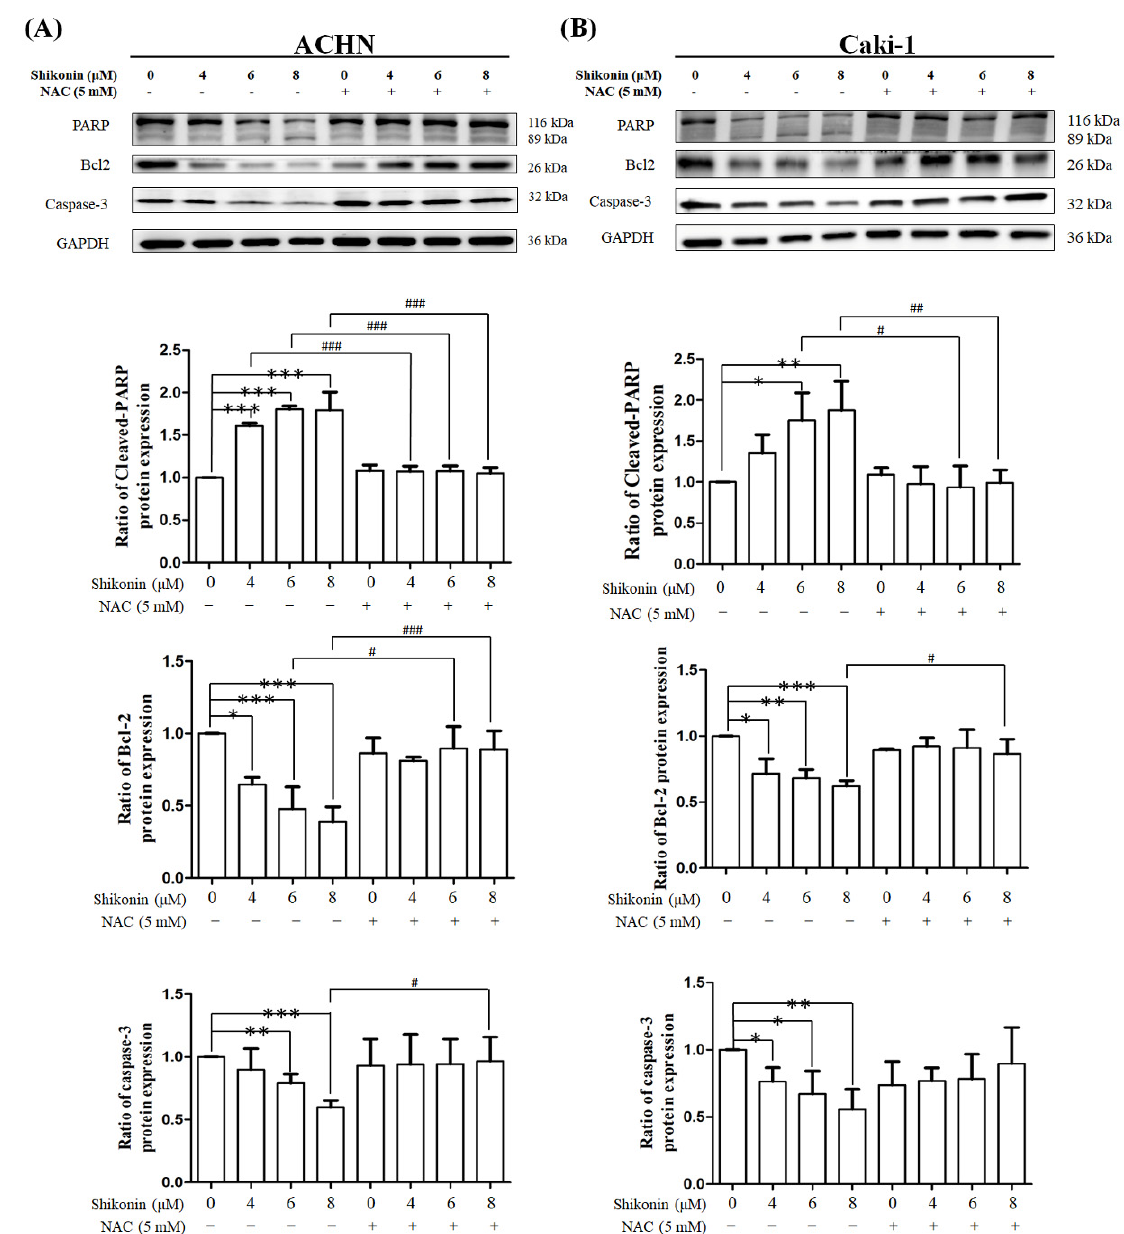
Figure 6. Shikonin affected the expression of apoptosis-related proteins. ( A ) ACHN and ( B ) Caki-1 cells were treated with 0, 4, 6, and 8 μ M shikonin with or without pretreatment with NAC. The cell lysates were analyzed by Western blot using the indicated primary antibody. Data represent means ± standard deviation from at least three independent experiences. * p < 0.05, ** p < 0.01, and *** p < 0.001 compared with the control group. # p < 0.05, ## p < 0.01, and ### p < 0.001 compared with the NAC pretreated group. Glyceraldehyde 3-phosphate dehydrogenase (GAPDH) was used as the internal